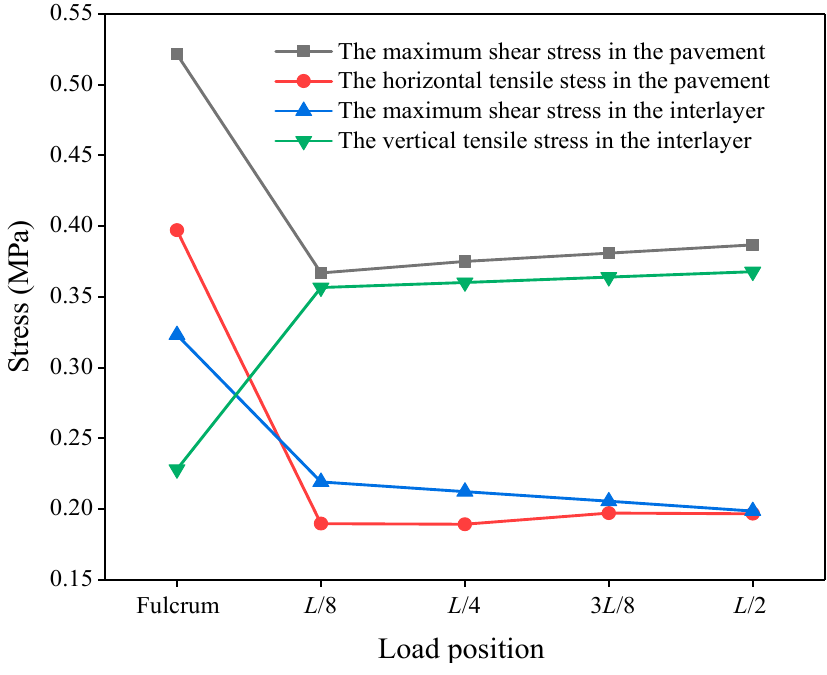
Figure 3. Longitudinal stresses in the pavement at different loading positions.